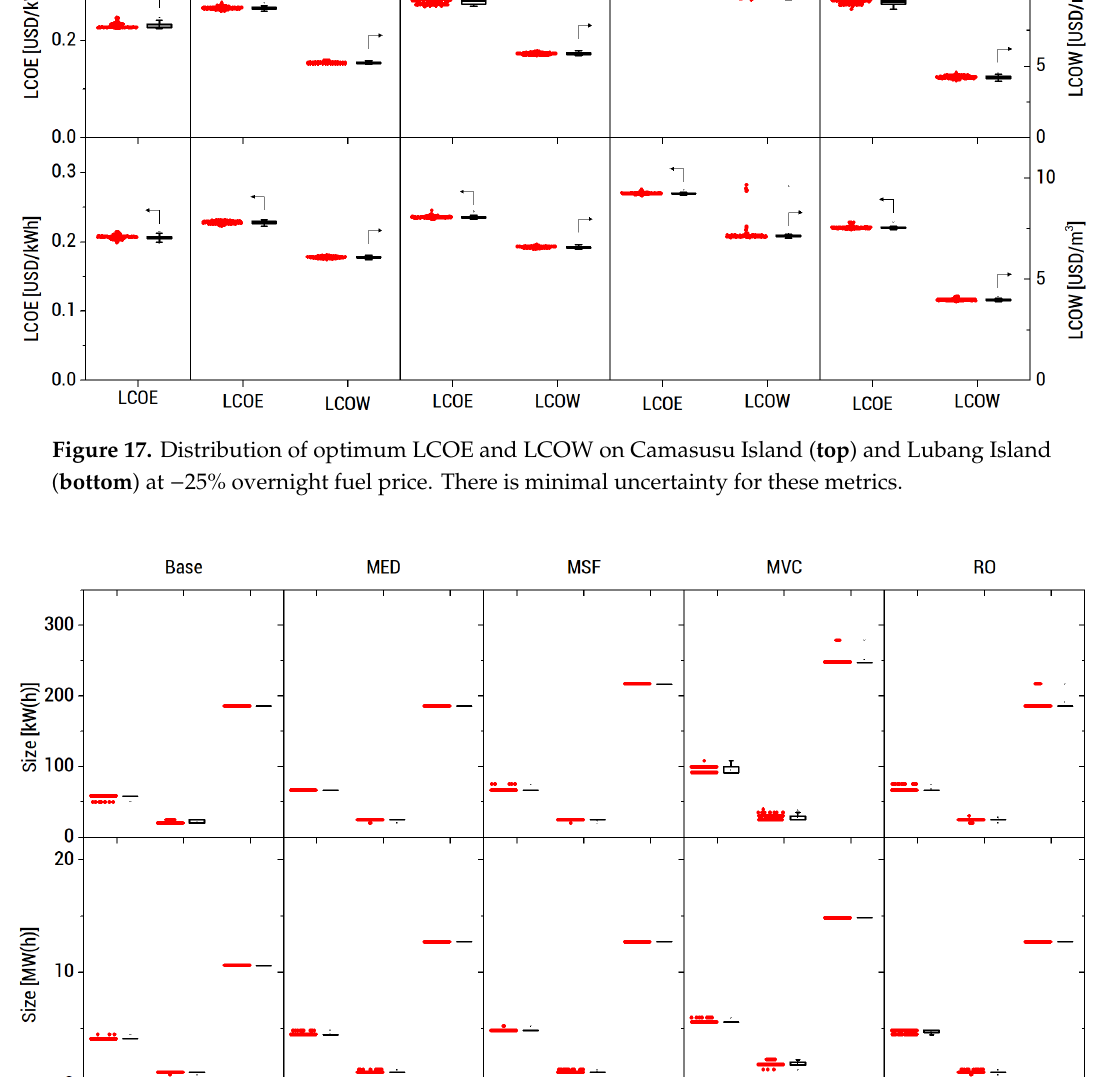
Figure 18. Distribution of optimum sizes of energy components on Camasusu Island ( top ) and Lubang Island ( bottom ) at + 25% overnight fuel price.